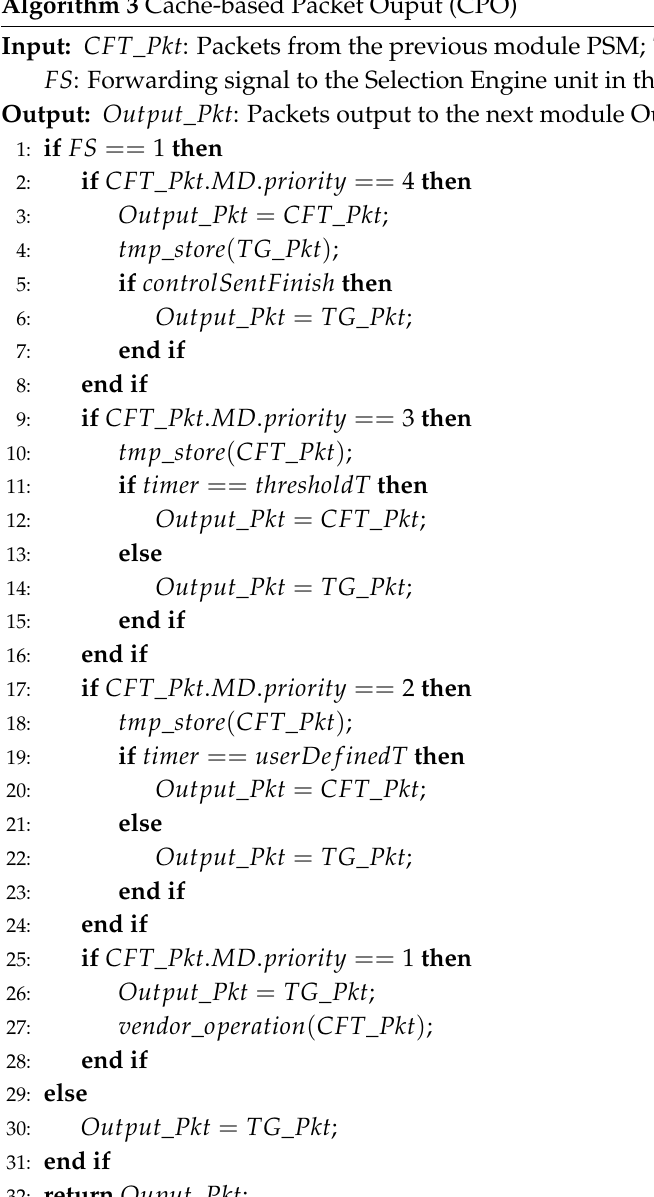
Algorithm 3 Cache-based Packet Ouput